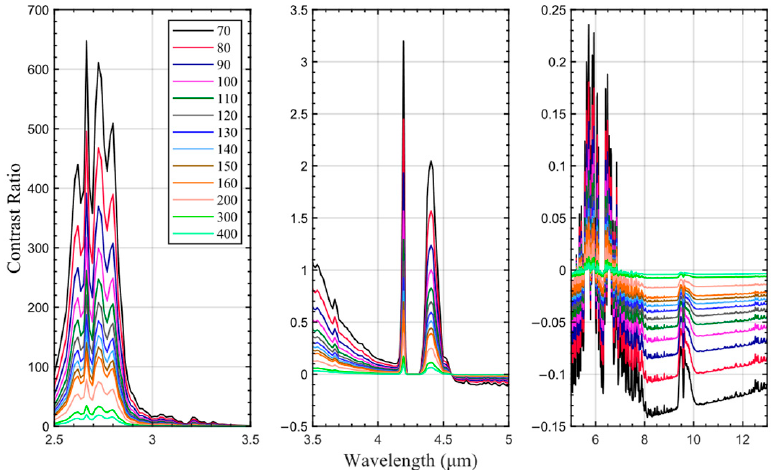
Figure 11. Spectral contrast of target and background at different GSDs of 70–400 m.